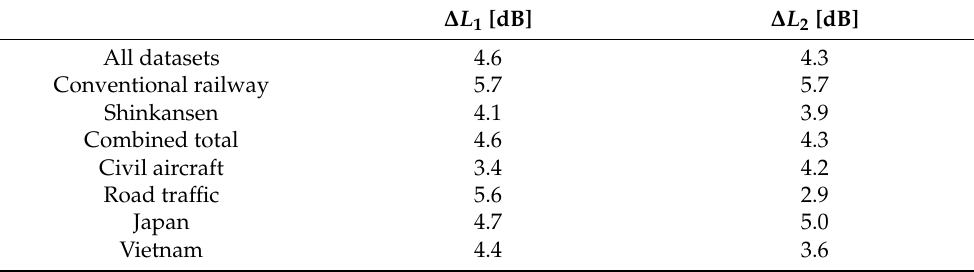
Table 3. Averages of ∆ L 1 and ∆ L 2 derived from exposure–response relationships estimated for each